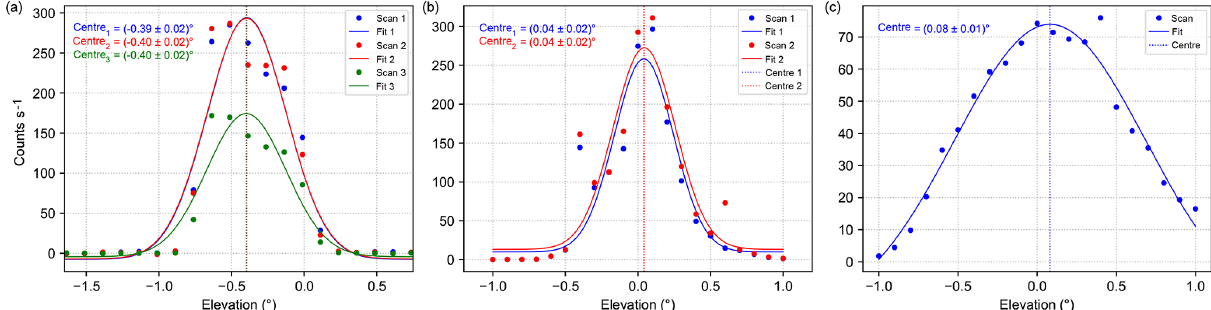
Figure 12. (a) Intensity curves at 365nm recorded on 10 September by the AUTH instrument. (b) Intensity curves at 546nm recorded on 13 September by the BOKU instrument. (c) Intensity curve at 546nm recorded on 13 September by the IUP-B visible instrument.